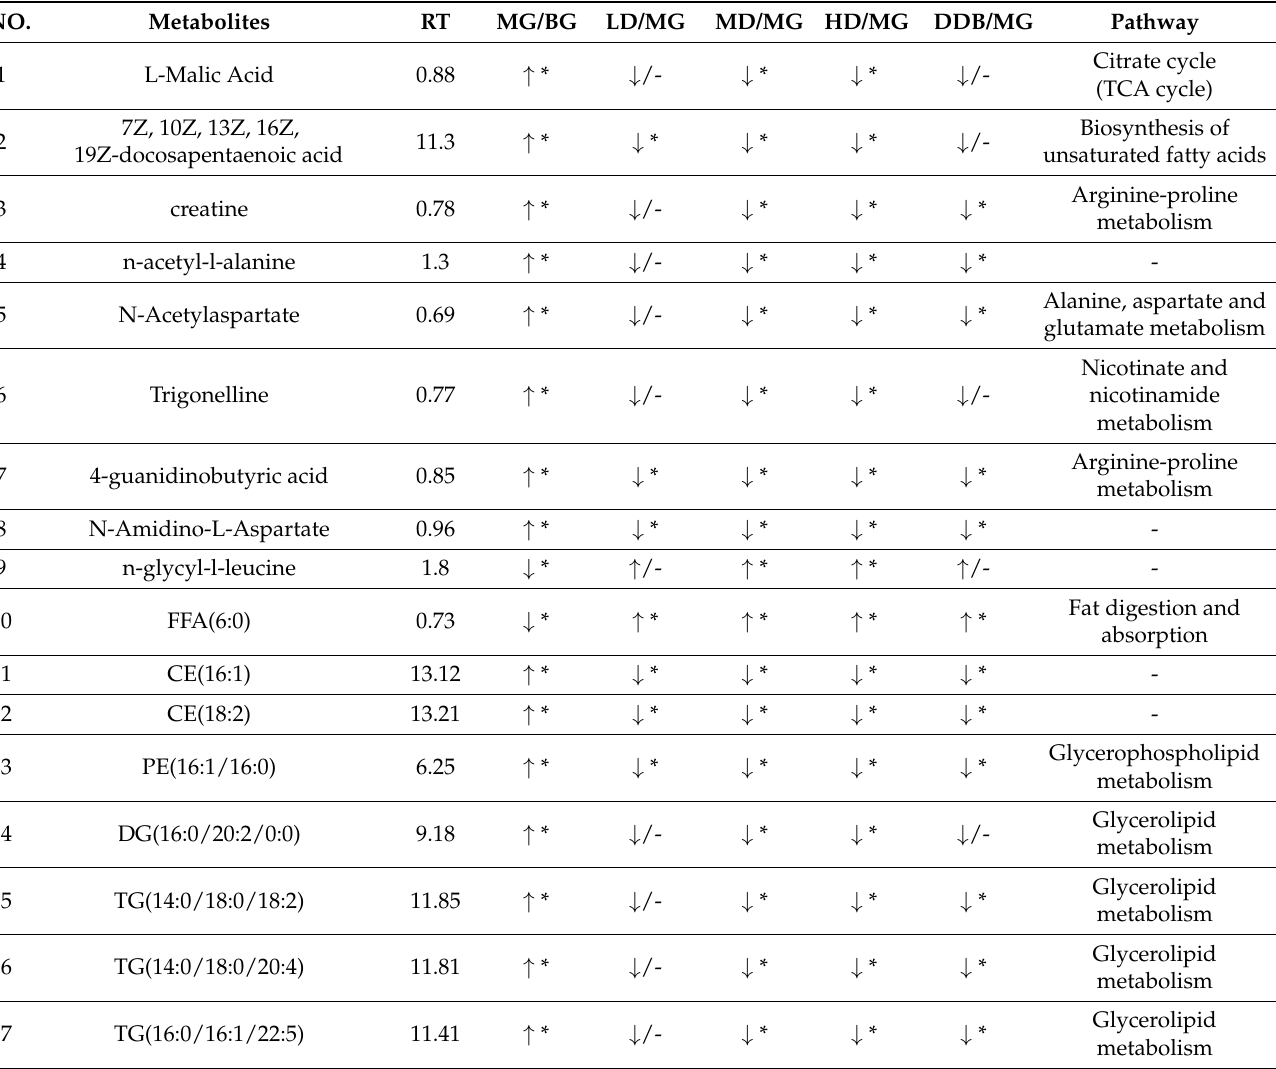
Table 2. Effects of SBS on metabolic in liver tissues of rats with acute liver injury induced by CCl 4 (X ± s, n =